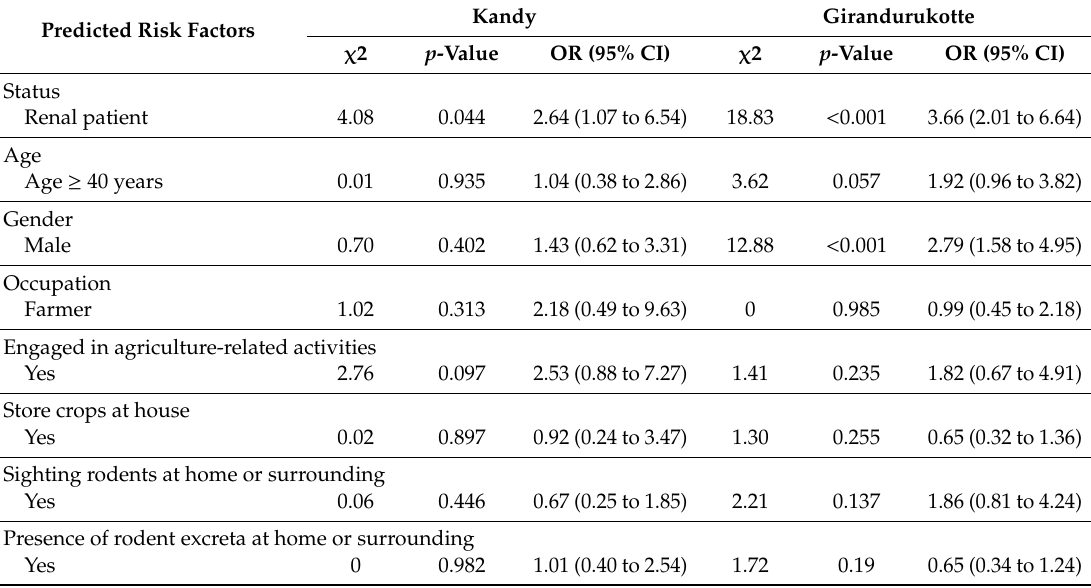
Table 3. Results of the binary logistic regression models for Kandy and Girandurukotte for prediction of the risk of an individual being seropositive for